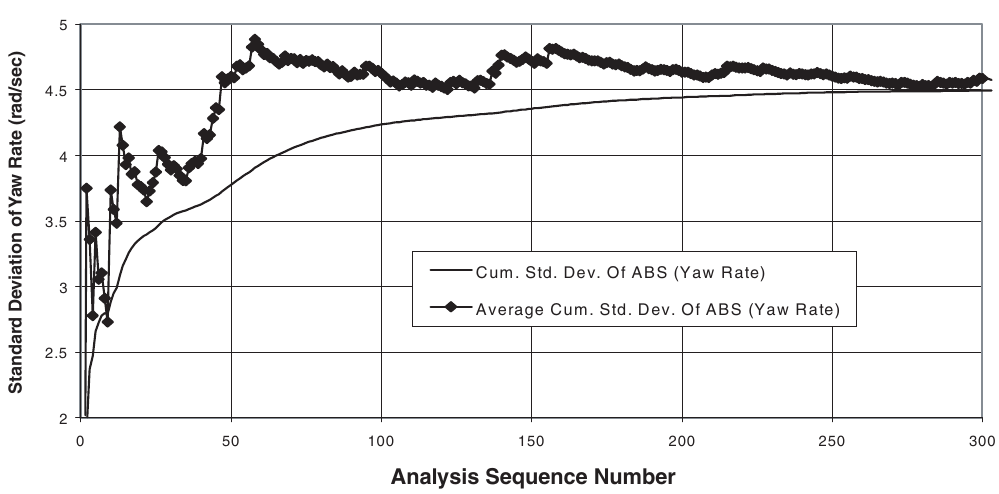
Fig. 4. Analysis sequence No. vs. cumulative standard deviation of yaw